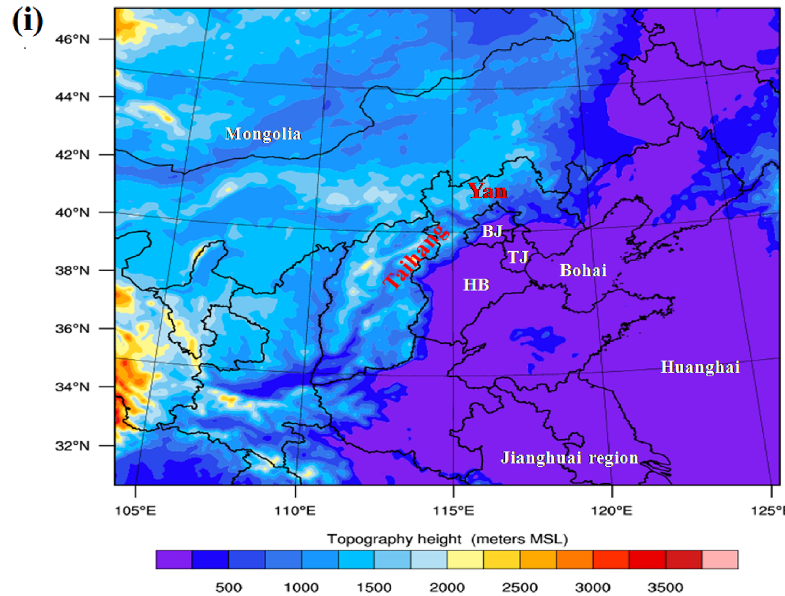
Figure 1. Sea level pressure (unit: hPa, left), geopotential height of 925hPa (unit: gpm, right), and wind field (wind direction bar) for the four heavy pollution weather types in the Beijing area: (a,e) type 1, (b,f) type 2, (c,g) type 3, and (d,h) type 4. Topography height of the North China ( i , unit: m). BJ, TJ, and HB represent Beijing, Tianjin, and Hebei. Yan and Taihang represent the Yan and Taihang Mountains.